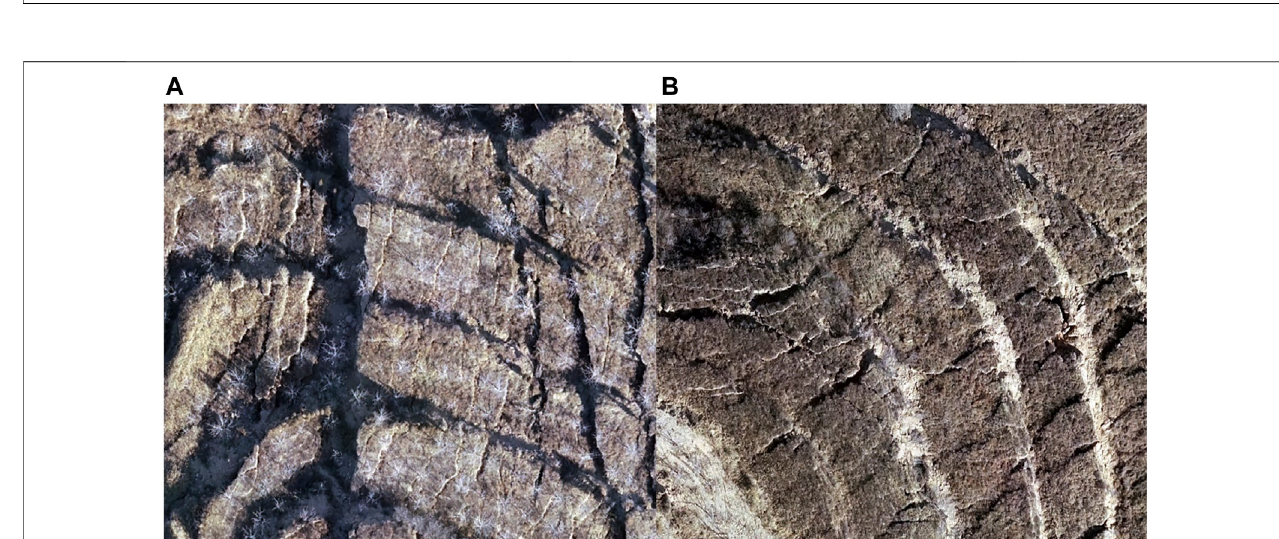
FIGURE 6 | Visual interpretation of ground fi ssures acquired by UAV.